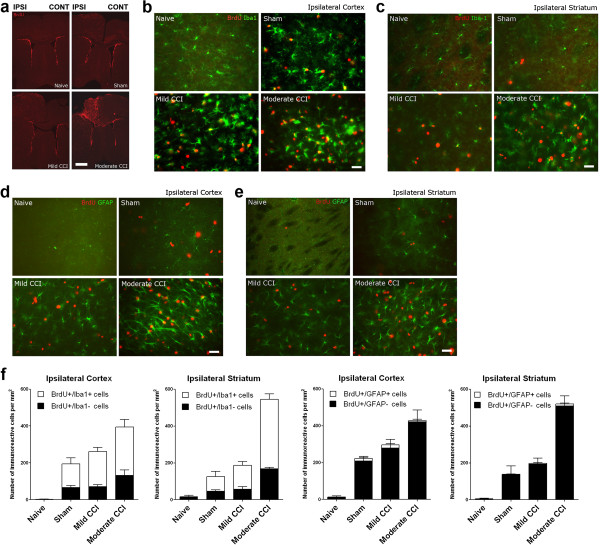
Unilateral trauma to the somatosensory cortex increases cell proliferation in the cerebral hemisphere ipsilateral to the CCI/sham. (a) Short-term BrdU incorporation analysis reveals widespread activation of cell proliferation in the cerebral hemisphere ipsilateral to the CCI or sham craniotomy. Mice were processed for anti-BrdU IHC at 74 hours post-procedure following BrdU injections at 0, 24, 48 and 72 hours post-procedure. In each image panel the cerebral hemisphere ipsilateral (IPSI) to the CCI/sham is on the left, the contralateral (CONT) hemisphere is on the right. Scale bar = 1 mm. (b and c) Co-immunolabeling of anti-Iba1 antisera (green), a marker for microglia and macrophages, with anti-BrdU + (red) reveals numerous co-immunoreactive cells in the (b) cortex and (c) striatum of the cerebral hemisphere ipsilateral to the CCI or sham craniotomy. Scale bars = 20 μm. (d and e) Co-immunolabeling with anti-GFAP antisera (green), a marker for reactive astrocytes, reveals astrogliosis in the (d) cortex and (e) striatum of the cerebral hemisphere ipsilateral to the CCI or sham craniotomy but minimal astrocyte contributions to the BrdU + cell population (red). Scale bars = 20 μm. (f) Quantification of immunolabeled cell numbers in the ipsilateral cortex and striatum reveals a graded increase in BrdU + cell numbers with increasing injury severity. Co-immunoreactivity to anti-Iba1 antisera confirms the majority (>50%) of these BrdU + cells are proliferating microglia or macrophages in CCI and sham mice, whereas astrocytes account for only 2-7% of the BrdU + cell population (n = 4-12/group).